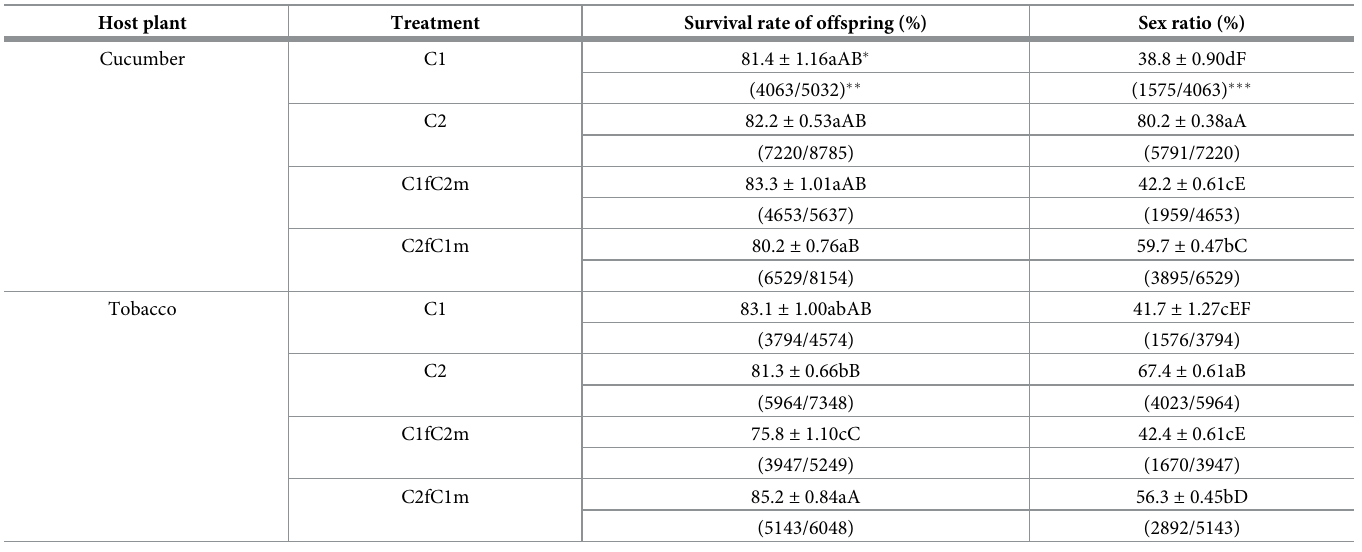
Table 4. Survival rate and sex ratio (mean ± S.E.) in offspring of B . tabaci .